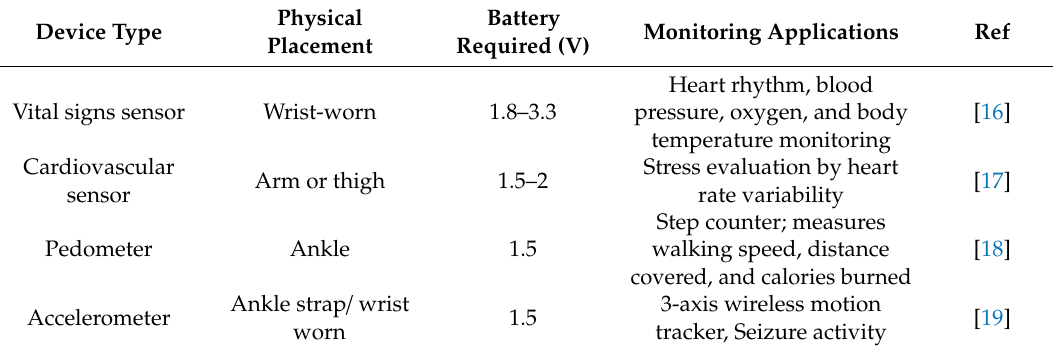
Table 1. Applications of di ff erent wearable low power body